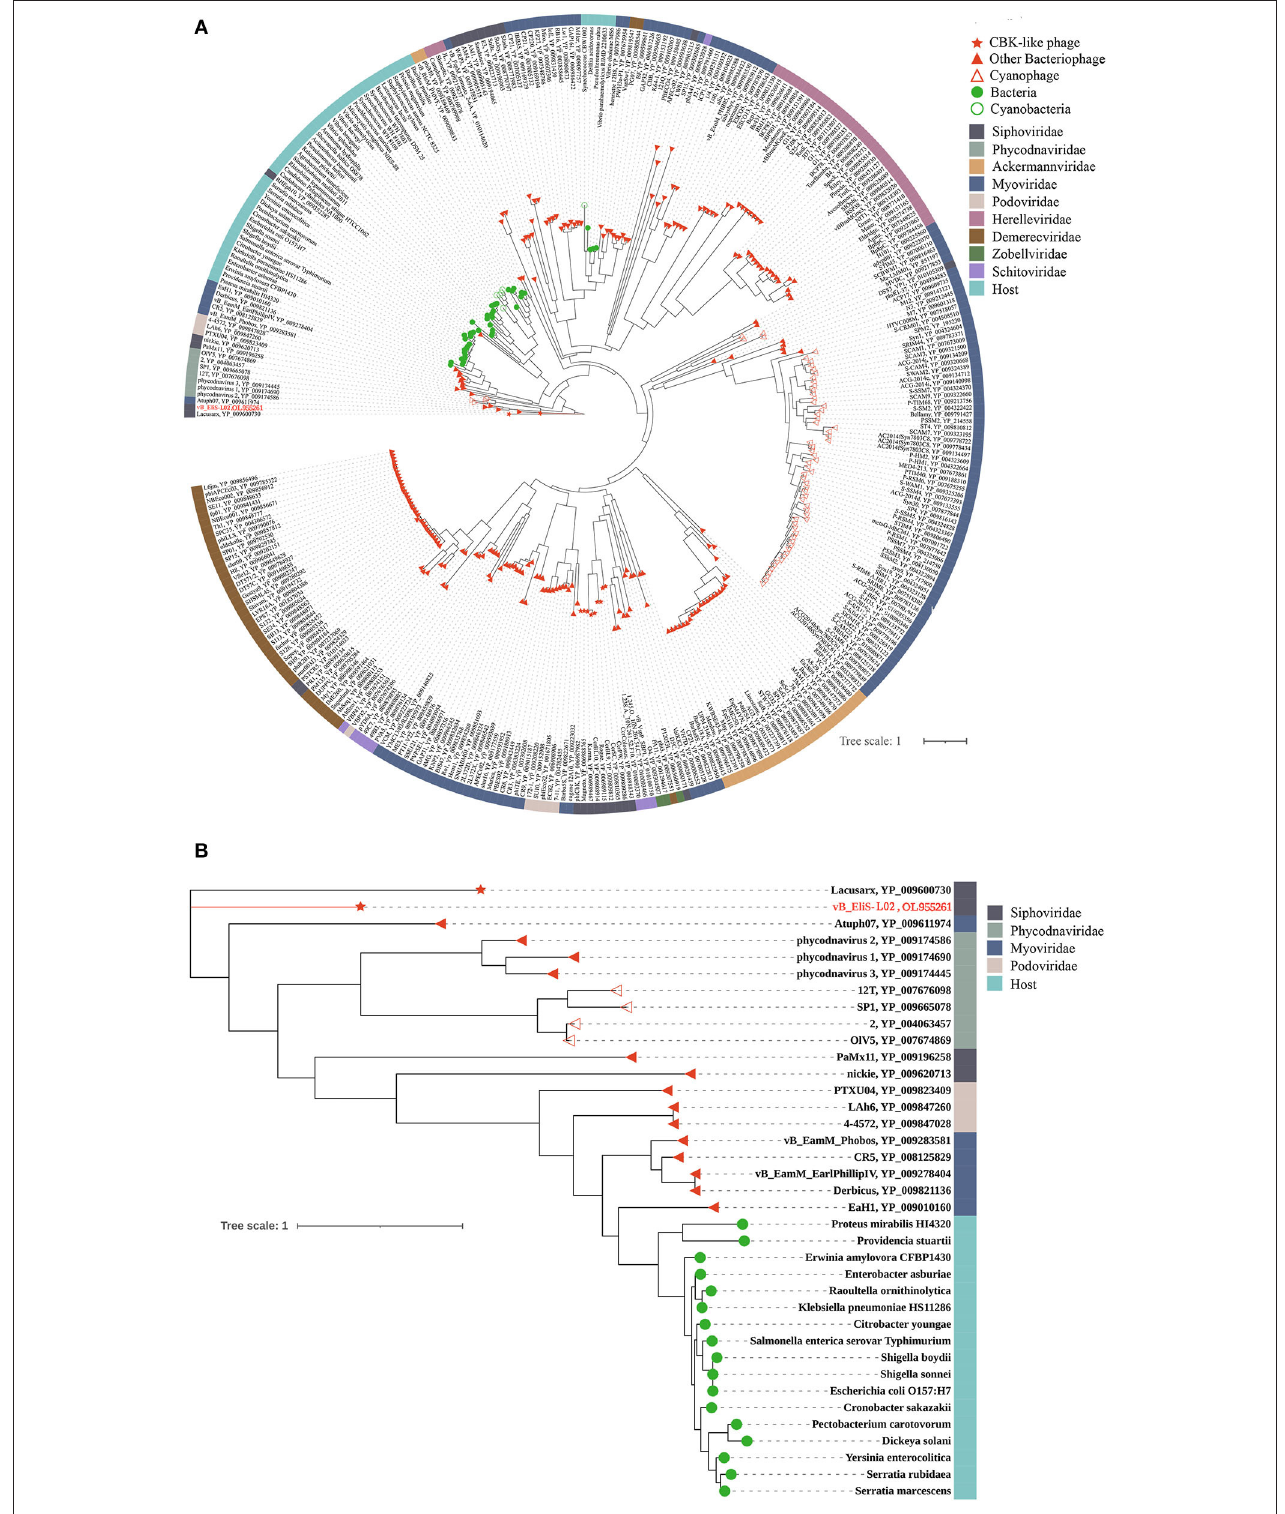
FIGURE 5 | (A) phoH-based phylogenetic tree constructed by IQtree showing the relationships among phages and their hosts and (B) local phylogenetic tree showing the details of the distribution patterns related to phage vB_EliS-L02. Each virtual family or bacteria is represented by a unique color. Phage vB_EliS-L02 is colored in